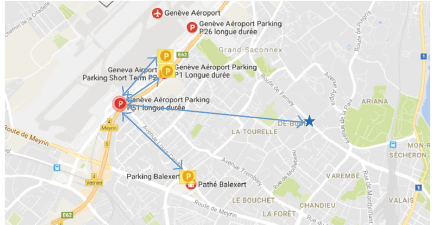
Figure 3: A communication scenario between three parking places represented by 𝑃 and a user represented by a star. The red circle is the place of interest for the user whereas the yellow rectangles are the parking in the neighborhood where the user needs to get information